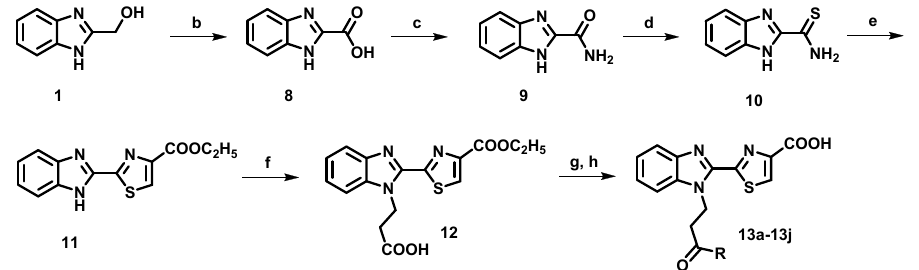
Table 1. The structure and inhibitory activity against Pin1 of 6a–6o and 7a–7c .